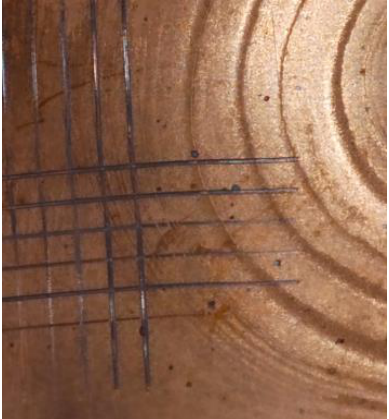
Figure 5. Photograph of a PEEK-copper composite made by chemical plating, after cross-hatch and peel test. peel